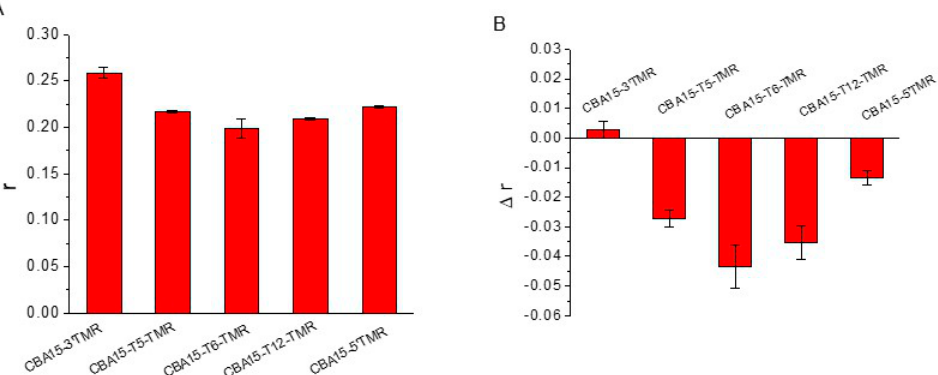
Figure 2. ( A ) FA responses of CBA15 with TMR labels at different sites (20 nM). ( B ) FA changes of TMR-labeled CBA15 caused by 500 nM Cd 2+ . Δ r was obtained by subtracting the FA values of the blank sample from the FA values of 500 nM Cd 2+ .